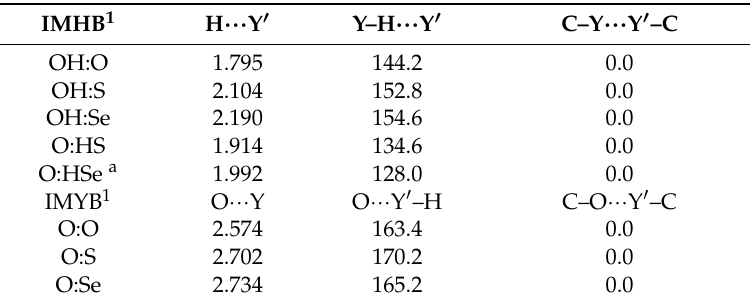
Table 1. Bond lengths (Å), Y–H ··· Y (cid:48) angles and dihedral C–Y ··· Y (cid:48) –C angles ( ◦ ) for the different compounds at MP2/aug-cc-pVDZ computational level.